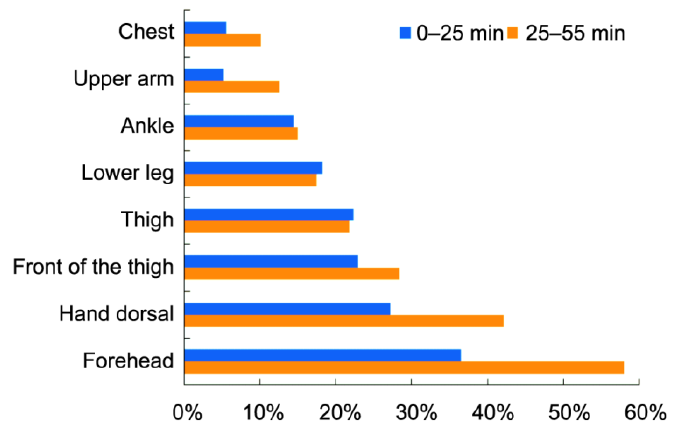
Figure 5. Temperature-change rates on different body parts of the participants at the 24 °C condi- tion.